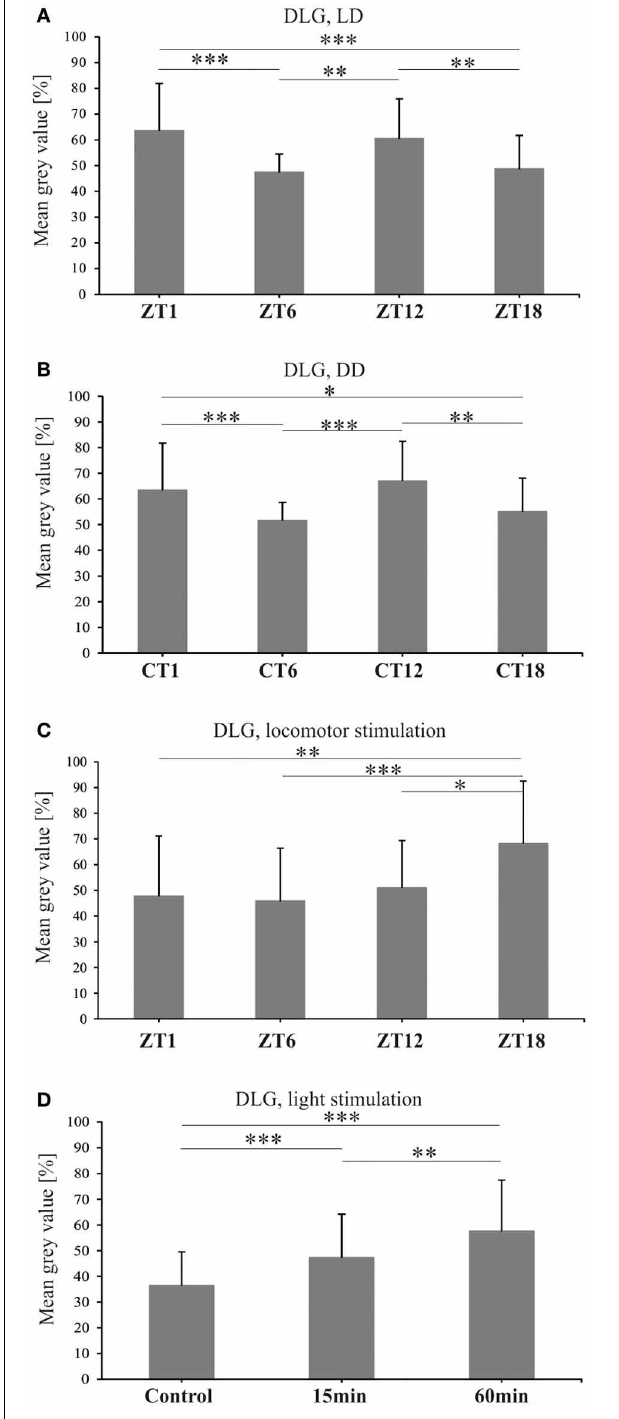
FIGURE 7 | DLG-specific immunofluorescence (brightness) measured from confocal images of the fly’s lamina. In both LD 12:12 (A) and DD (B) the level of DLG oscillates and its pattern is similar in both conditions with two peaks at ZT1 or CT1 and ZT12 or CT12. One hour of locomotor stimulation changes the rhythm of DLG (C) . Light stimulation increases DLG abundance in the lamina of wild type flies (D) ( ∗ p ≤ 0 . 05, ∗∗ p ≤ 0 . 01, ∗∗∗ p ≤ 0 .